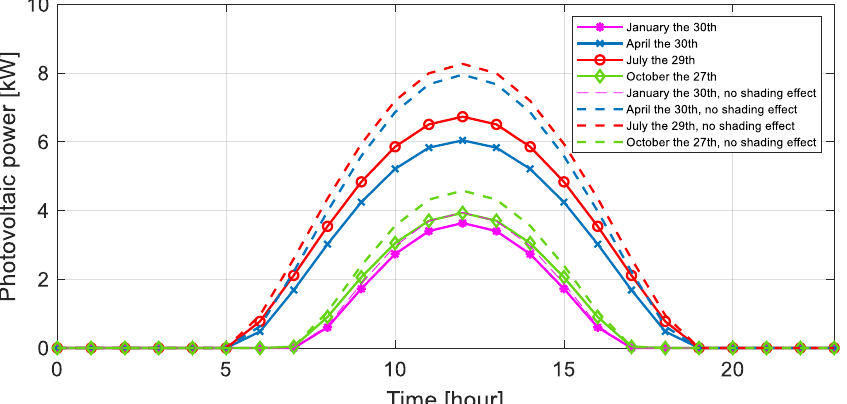
Figure 4. Hourly photovoltaic power.